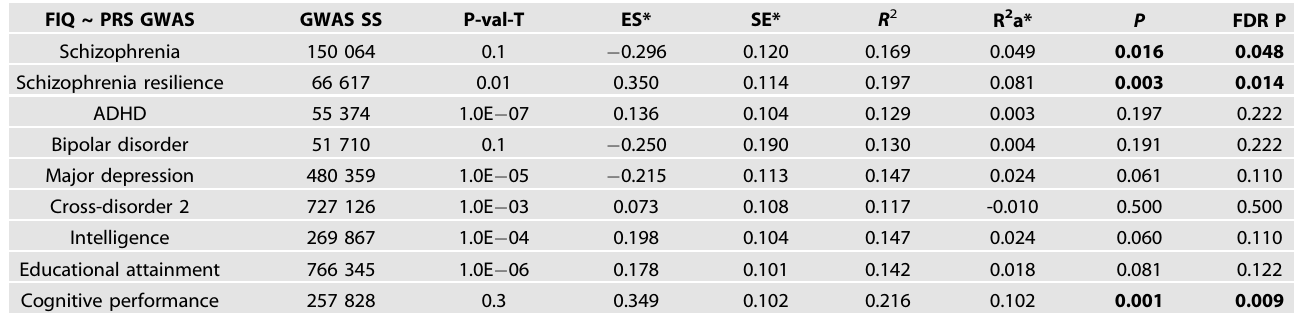
Table 2. Linear regression of full WAIS IQ on PRS adjusted on age, sex and population